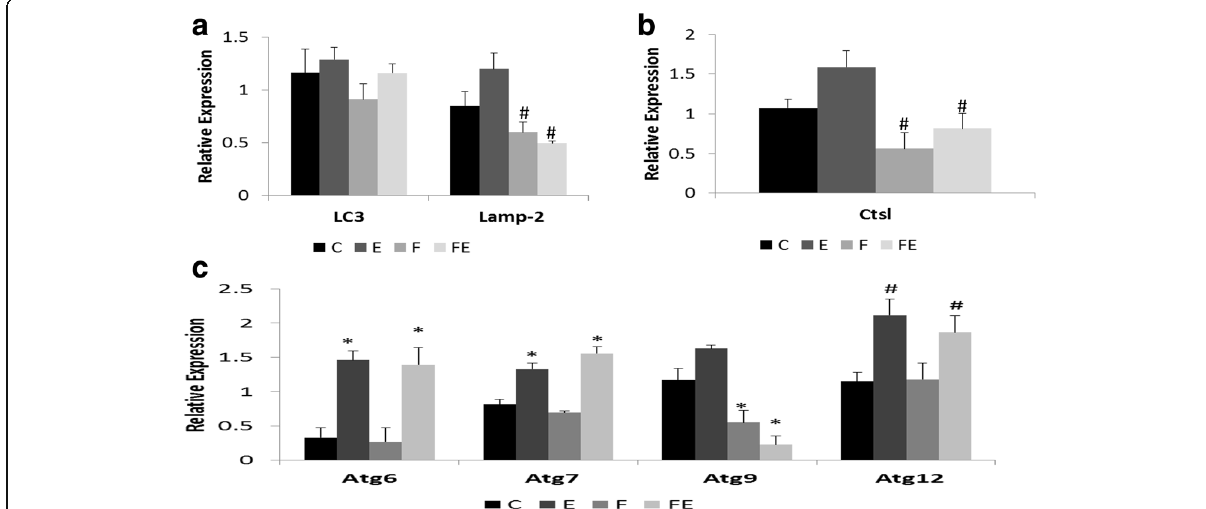
Fig. 3 Impact of aerobic training or fructose ingestion on expression of autophagy genes. a Marker of autophagosome accumulation LC3 and lysosomal-associated membrane glycoprotein Lamp-2. b Lysosomal cathepsin L Ctsl. c Atg genes. Groups: C control, E exercise, F fructose, FE fructose + exercise. Results are presented as mean±SEM. A statistically significant main effect of exercise on expression of Atg6, Atg7, and Atg12 was observed. There is also a main effect of fructose ingestion on expression of Atg9, Lamp-2, and Ctsl as well as an interaction between fructose and exercise on expression of Atg9. See the text for further details. * p < 0.001, # p <